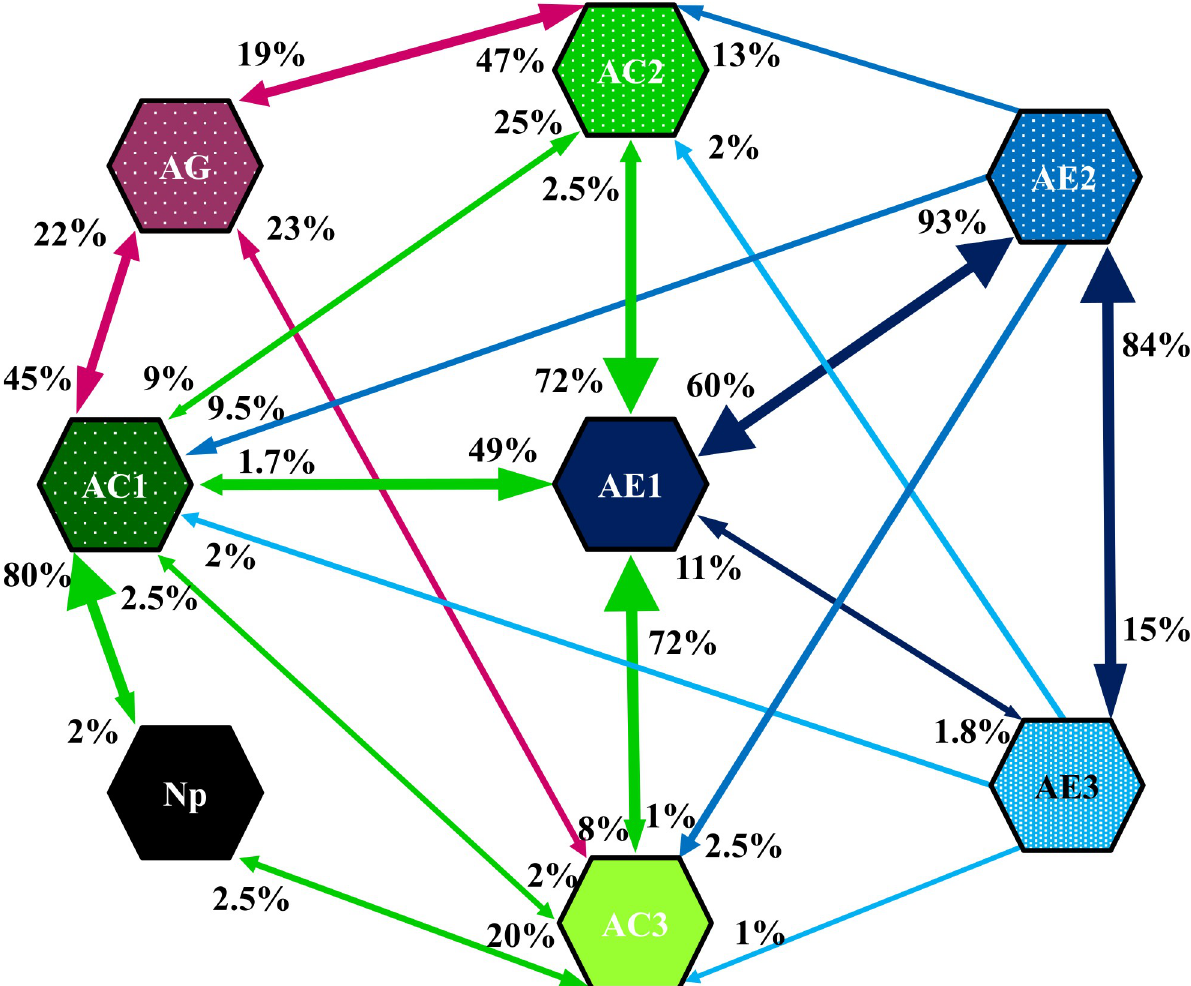
Fig 10. Kinetogram of behavior during stylet penetration of Adelges laricis on Larix decidua . The values near the arrowheads indicate the occurrence (%) of transitions from one waveform to the next that occurred in all (n = 84) EPG recordings. Anp–non-probing (black labels). AC1, AC2, AC3 –variants of pathway phase AC (green labels). AE1, AE2, AE3 –variants of phloem phase AE (blue labels). AG–xylem phase (purple label).